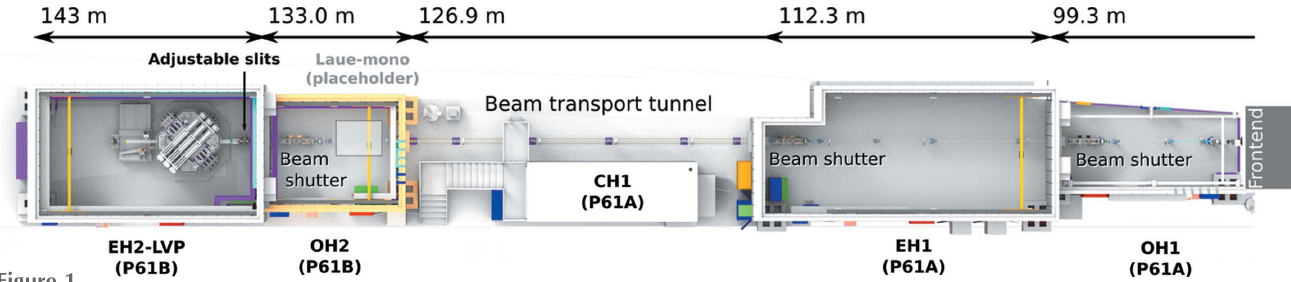
Figure 1 Beamline P61 in sector 1 of the P. P. Ewald hall (PXN) of PETRA III. The distances correspond to the center of the last damping wiggler. The beamline comprises the independently run stations P61A (operated by HZ-Hereon) and P61B LVP (operated by DESY) and share beam time equally. P61B continues to operate the LVP without X-rays for regular users. Both sections of the beamline have a user sample preparation laboratory (not shown). Additionally, P61B runs a dedicated laboratory with a benchtop X-ray diffractometer